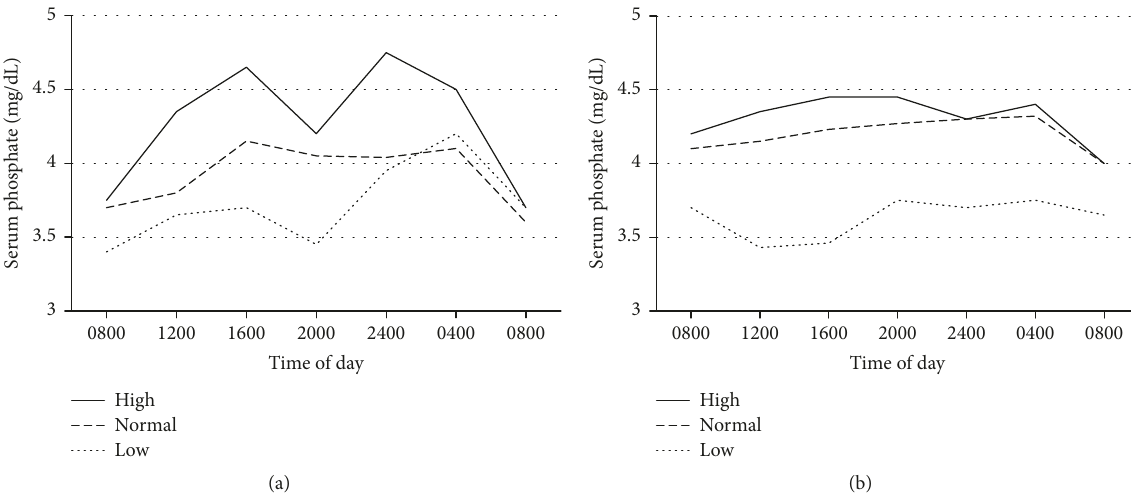
Figure 3: Serum phosphate concentrations throughout the day in healthy controls (a) and CKD patients (b). High phosphate = 2500 mg/day; normal phosphate = 1500 mg/day; low phosphate = 1000mg/day plus lanthanum carbonate. Adapted from Ix et al. [4]. Reuse under the copy- right license of free access article from American Society of Nutrition.